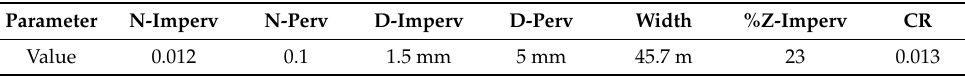
Table 5. Main parameter values in computing runoff–yield process and pipe flow calibrated in